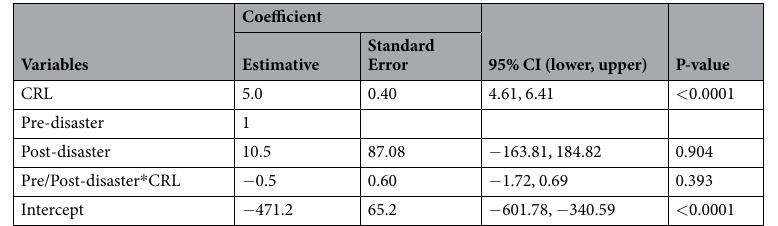
Table 4. Multiple linear regression for body weight in Japanese monkey fetuses in Fukushima (n = 62). R 2 = 0.85; adjusted R 2 =